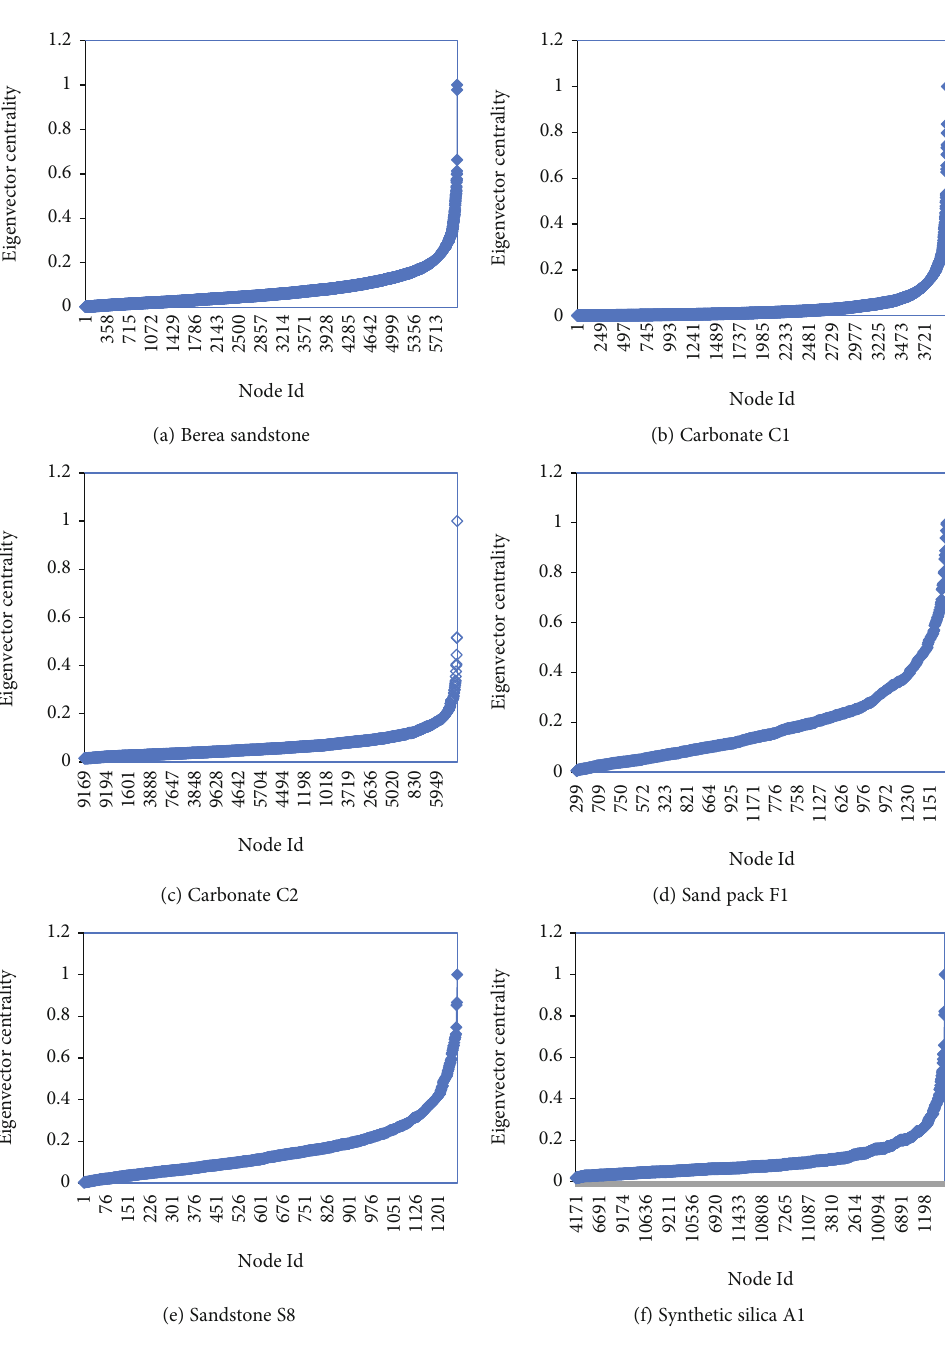
Figure 4: Eigenvector centrality distribution of